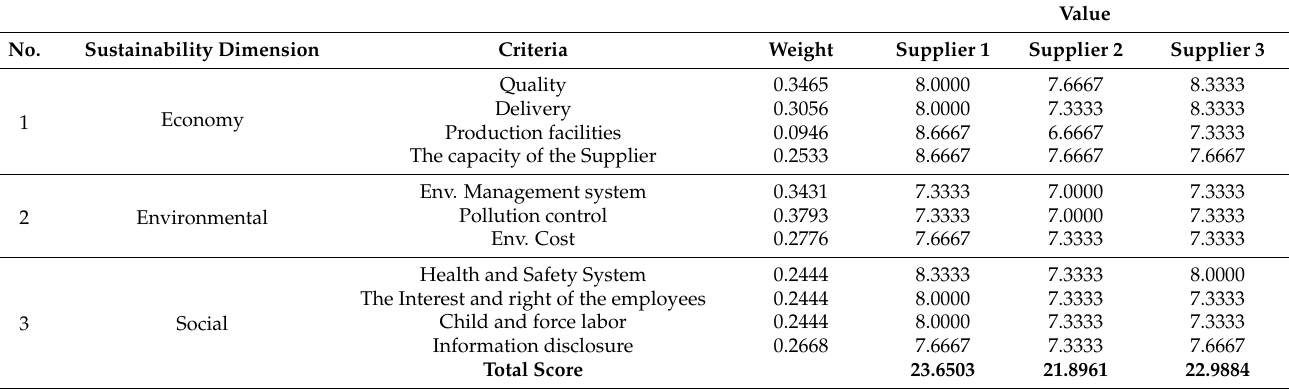
Table 6. Decision Matrix Result.